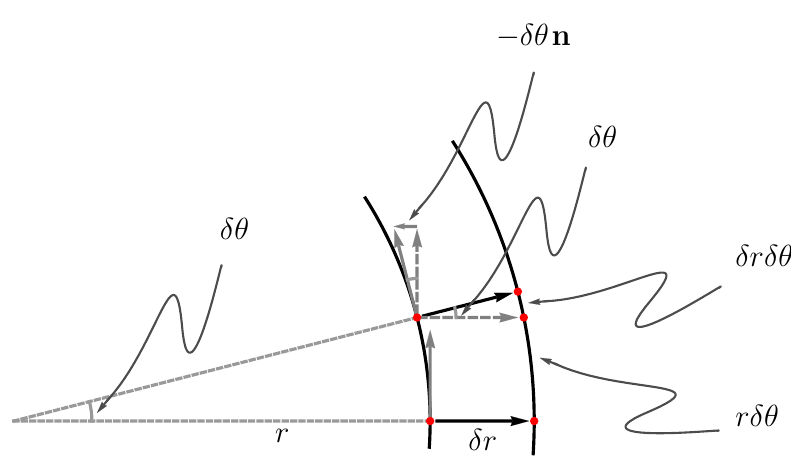
Figure 1 . The calculation of the extrinsic curvature for a cylinder embedded in a flat space. The last term in this equation expresses the extrinsic curvature in terms of the derivatives of the